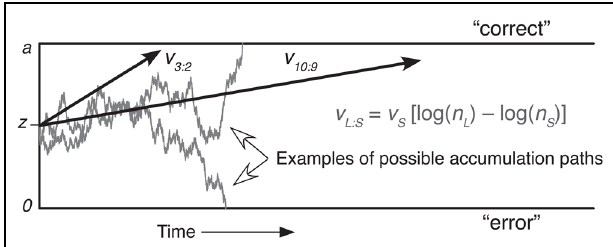
FIGURE 1 | A schematic illustration of the diffusion model in the context of a numerosity comparison task. Here, trials with the larger number on the left and those with the larger number of the right are collapsed to represent boundaries for “correct” and “error” responses on each side. n L is the larger and n S is the smaller of the two numerosities. v L : S represents the drift rate for each individual ratio condition.